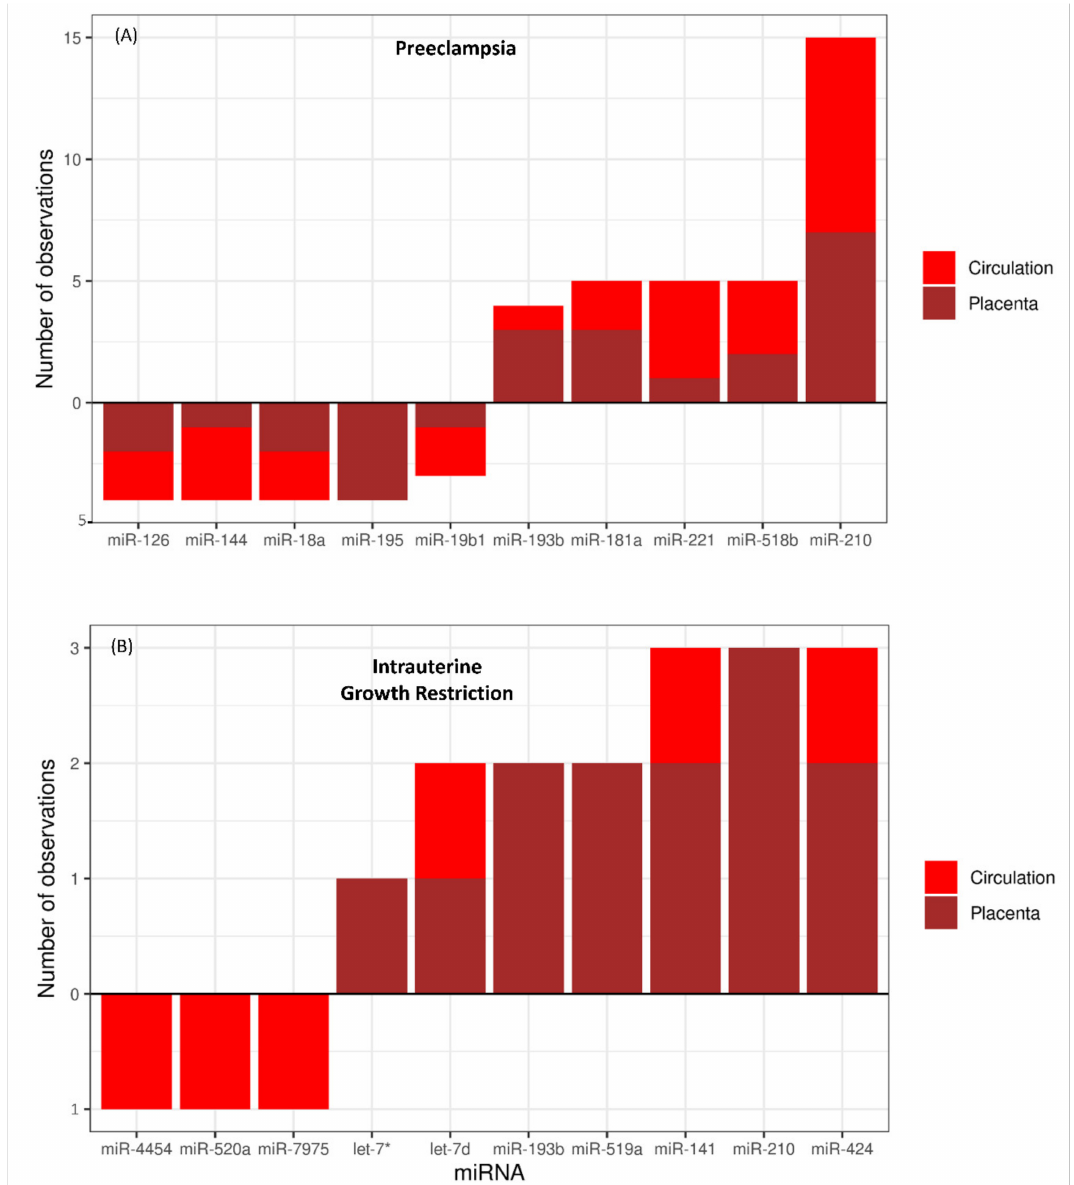
Figure 1. ( A ) Number of observations linking upregulated and downregulated miRNAs to PE. A total of 15 different studies linked upregulation of miR-210 with the pathogenesis of PE, eight times in circulation and seven times in the placenta. ( B ) Number of observations linking upregulated and downregulated miRNAs to IUGR. Three different studies linked upregulation of miR-424 with the pathogenesis of IUGR, one time in circulation and two times in the placenta. Bars rising above zero x -axis reference line indicate upregulation, and bars hanging below zero x -axis reference line indicate downregulation. A complete list of miRNAs and the number of studies linking them to each disease is in Table S5. Let-7*: let-7a, let-7b, let-7c, let-7e, let-7f, let-7g or